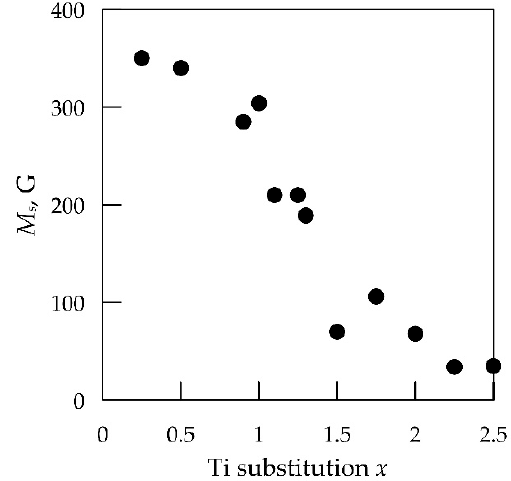
Figure 4. The saturation magnetization M s derived from LAS for BaFe 12 − x Ti x O 19 .